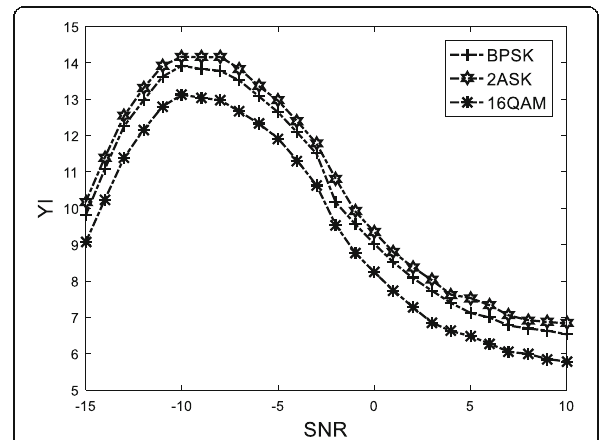
Fig. 11 Signal enhancement result after PSR. a 2ASK. b BPSK. c 16QAM